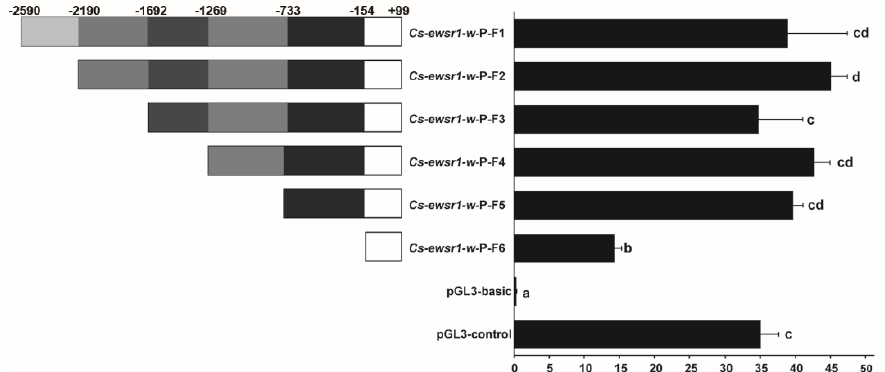
10 of 16 Figure 4. The relative expression patterns of Cs-ewsr1-w ( A ) and Cs-ewsr1-z ( B ) genes in female and male gonads from different developmental stages. Different letters represent significant differences among species ( p < 0.05). 3.3. Promoter Activity of Cs-ewsr1-w Detection and Analysis The Cs-ewsr1-w promoter sequence of 2,690 bp (-2,590/+99) was cloned by genomic DNA with specific primers Cs-ewsr1-w -P-F/R (Table 1). Cs-ewsr1-w promoter region had only one CpG island, which was located from -1,215 to -1,101 bp. A series of promoter fragments with different length deletion were generated to ex- plore the promoter activity of Cs-ewsr1-w gene. The promoter activities of all Cs-ewsr1-w fragments were significantly higher than that of pGL3-basic ( p < 0.05, Figure 5), among